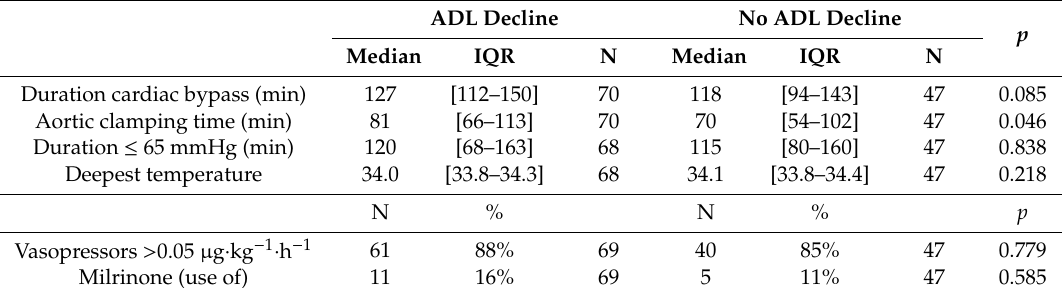
Table 2. Intraoperative parameters.